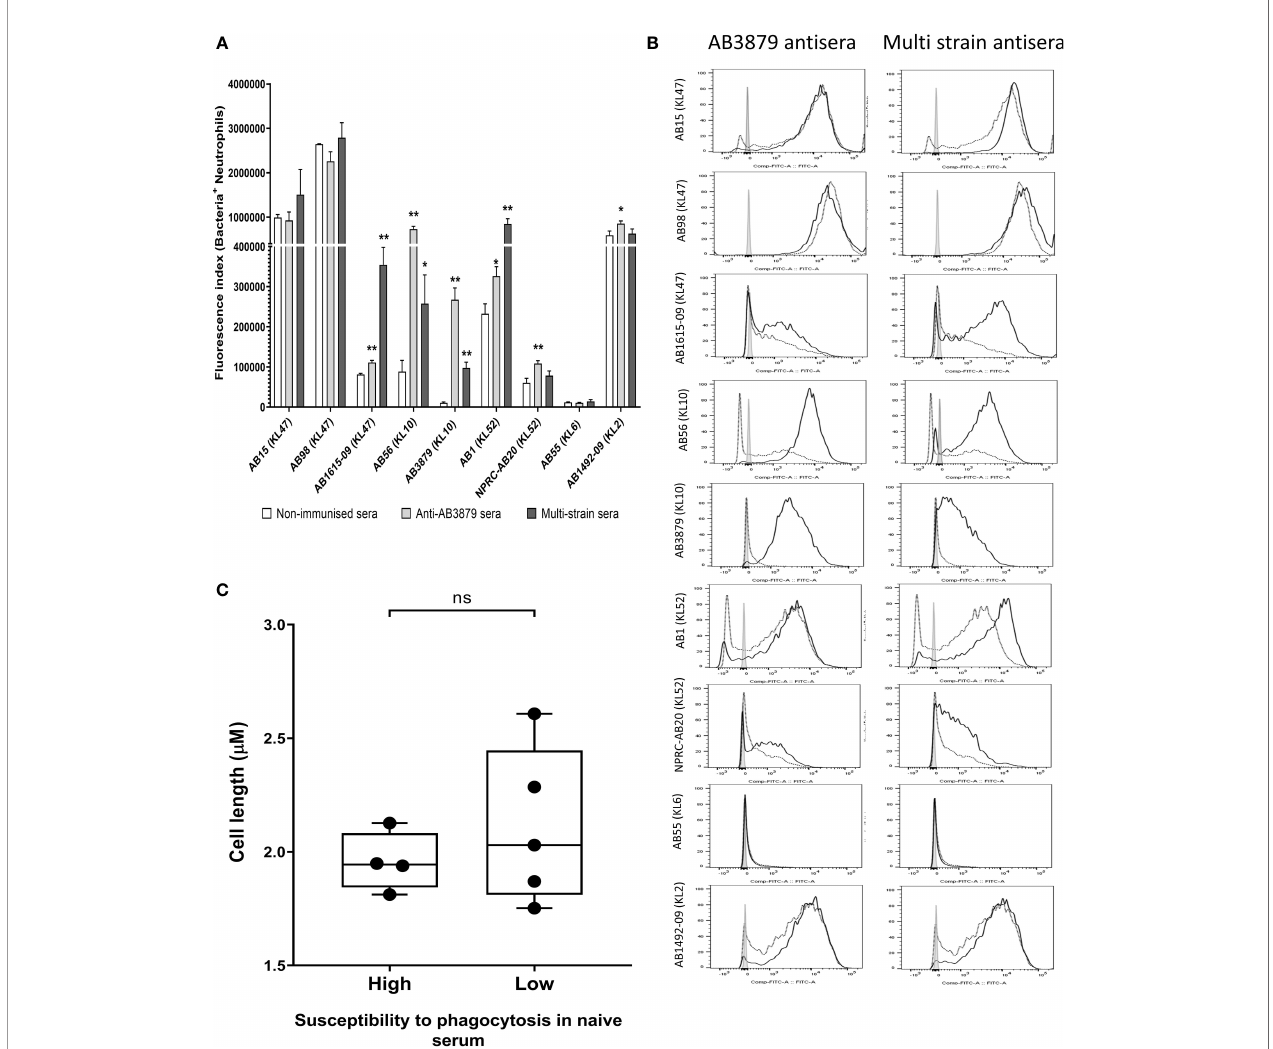
FIGURE 8 | Opsonophagocytosis by human neutrophils of a panel of nine A. baumannii isolates by mouse antisera generated following immunization with one strain or sequentially with three strains. Nine FAMSE labelled A. baumannii isolates were opsonized with either AB3879 antisera, multi strain antisera or sera from non- immunized mice and incubated with healthy human neutrophils at Bacteria: Neutrophil MOI of 100:1. (A) Shows the fl uorescence index calculated by multiplying the proportion (%) of FAMSE +ve neutrophils and the median fl uorescence intensity of the positive population [mean (±standard deviation)] on the Y axis and thenine isolates with theircapsule serotypes indicated in brackets are onthe X-axis. Phagocytosisindices inbacteria incubated with non-immune sera, anti-AB3879 sera and multistrain sera for each isolate isrepresented in the white, grey anddarkgrey barsrespectively. Bars represent mean values for each condition/strain tested intriplicate and the error bars indicate standard deviations(SDs) (n = 3). T-test was used for statistical analysis *p-value < 0.05, **p-value< 0.001, ***p-value< 0.0001, ns: p-value= not signi fi cant. Representativedata from two independent experiments isshown. (B) Representative histogramsshowingphagocytosisof FAMSE labelled A. baumannii isolates incubated with either AB3897 antisera (leftpanel)and multi strain antisera (right panel).Grey histogramsrepresent nosera (neutrophils only), black-dotted line represents addition of neutrophils to bacteria incubated with sera from non-immunized mice andblack solid line represents addition ofneutrophilsto bacteria incubatedwith the respective mouse antisera. The nine isolates andtheir respective KL class denoting the capsule serotypes are indicated alongside respective histograms. (C) Comparison of the capsule size in bacterial isolates thatshow low (N= 5) versus high (N= 4) susceptibility to neutrophilsphagocytosis. Box andwhisker plots represent mean values for each groupand the errorbars indicate the minimum and maximumvalue. Mann-Whitney U-test was used for statistical analysis *p-value< 0.05, **p-value < 0.01, ns: p-value=not signi fi